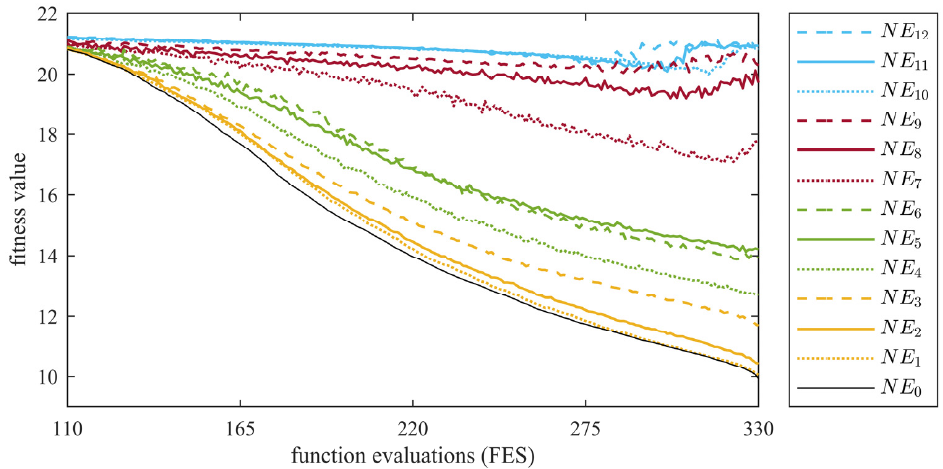
Figure 5. Convergence curves of MGP-SLPSO on 30-dimensional Ackley problem with different noise levels. noise